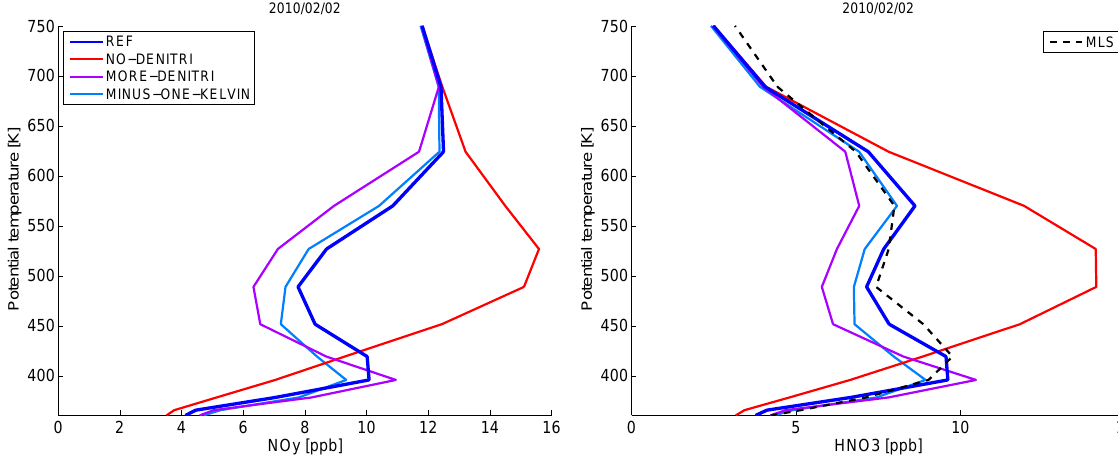
Fig. 12. Vortex-averaged NO y and HNO 3 for 2 February 2010 as a function of potential temperature for the relevant sensitivity runs (reference run REF, run with no denitrification NO-DENITRI and run with the nucleation rate multiplied by 10 MORE-DENITRI). The different sensitivity runs are represented by different colours. The left panel shows the total (solid and gas-phase) NO y , the red line (NO-DENITRI run) is identical to the passive NO y tracer. The right panel shows total HNO 3 (identical to gas-phase HNO 3 on this day). The black dashed line shows corresponding HNO 3 measurements from MLS. Vortex average as in Fig. 1.